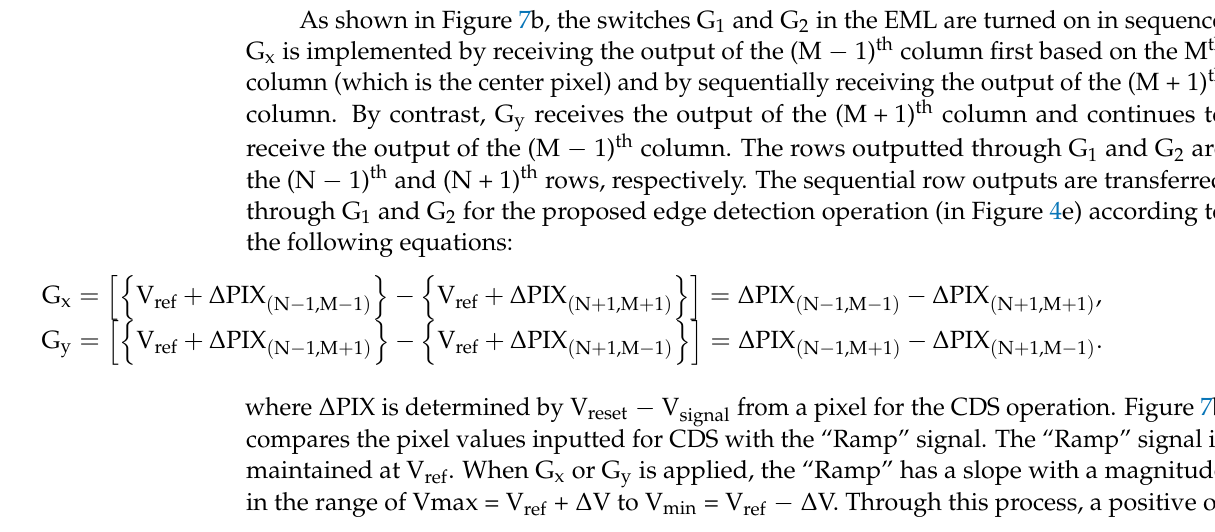
Figure 7. Schematics of ( a ) RBL and ( b ) EML.